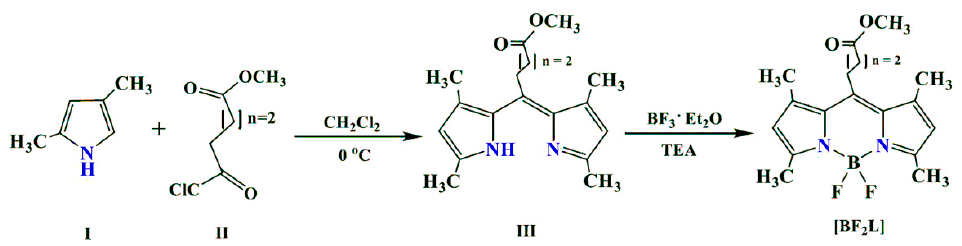
Figure 1. The synthesis scheme of [BF 2 L].